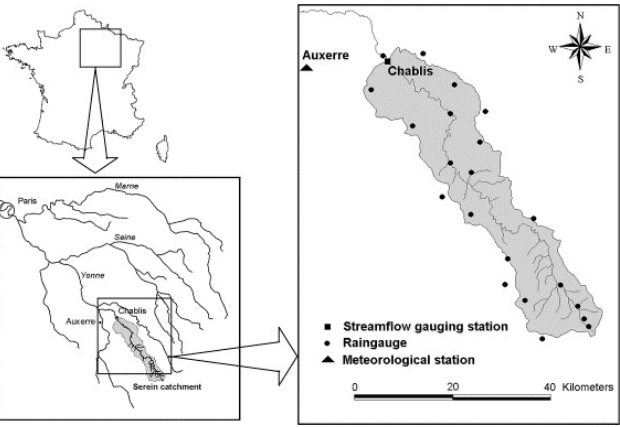
Fig. 2 Location of the Serein catchment in the Seine